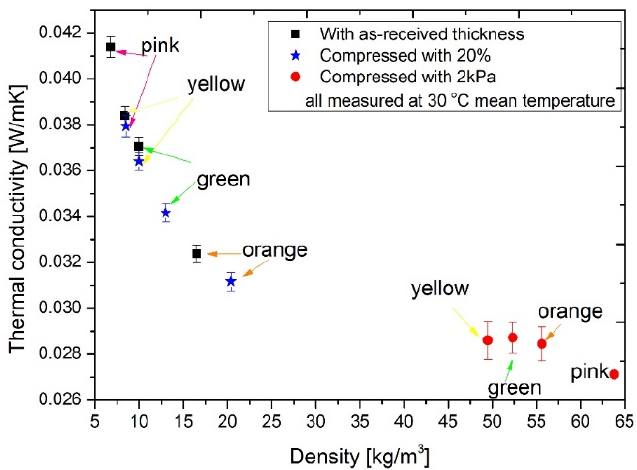
Figure 4. Thermal conductivity measurement results.